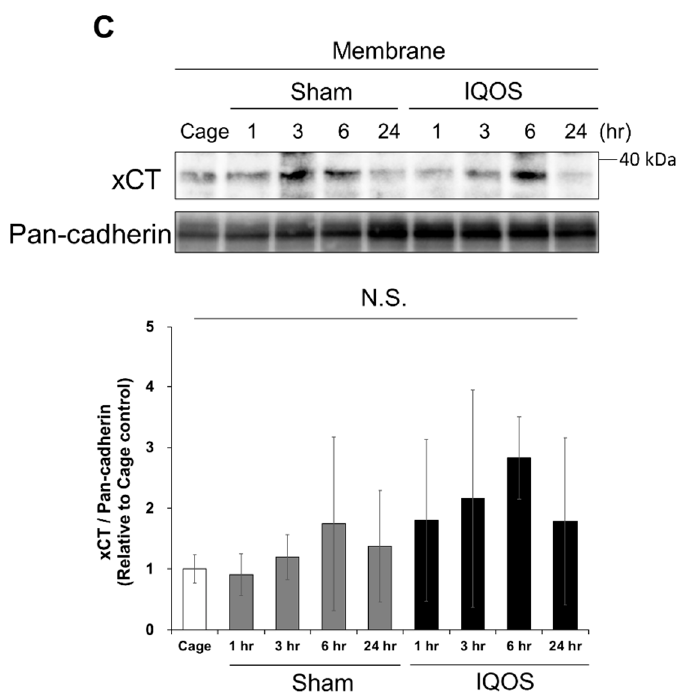
Figure 3. Effects of IQOS exposure on the eIF2 α -ATF4 axis in murine whole-lung tissue. ( A ) Expression analysis of p-eIF2 α and eIF2 α in the cytoplasmic fractions of the lungs from murine cage controls, sham controls, and at various times after exposure to IQOS. The densities of p-eIF2 α bands were measured, and the expression ratio to eIF2 α was calculated and expressed as a nor- malized fold-change relative to cage control mice. ( B ) The analysis of nuclear ATF4 expression in murine lungs of cage control, sham control, and various times after exposure to IQOS is shown. The density of ATF4 bands were measured, and the expression ratio normalized to LaminB1 was calculated and expressed as fold-change relative to cage control mice. ( C ) Expression analysis of xCT on cell membranes in the murine lungs of cage controls, sham controls, and at various times after exposure to IQOS. The density of xCT bands were measured, and the expression ratio normalized to Pan-cadherin was calculated and expressed as fold-change relative to cage control mice. * p < 0.05 versus cage control group. N.S.: not significant. N =